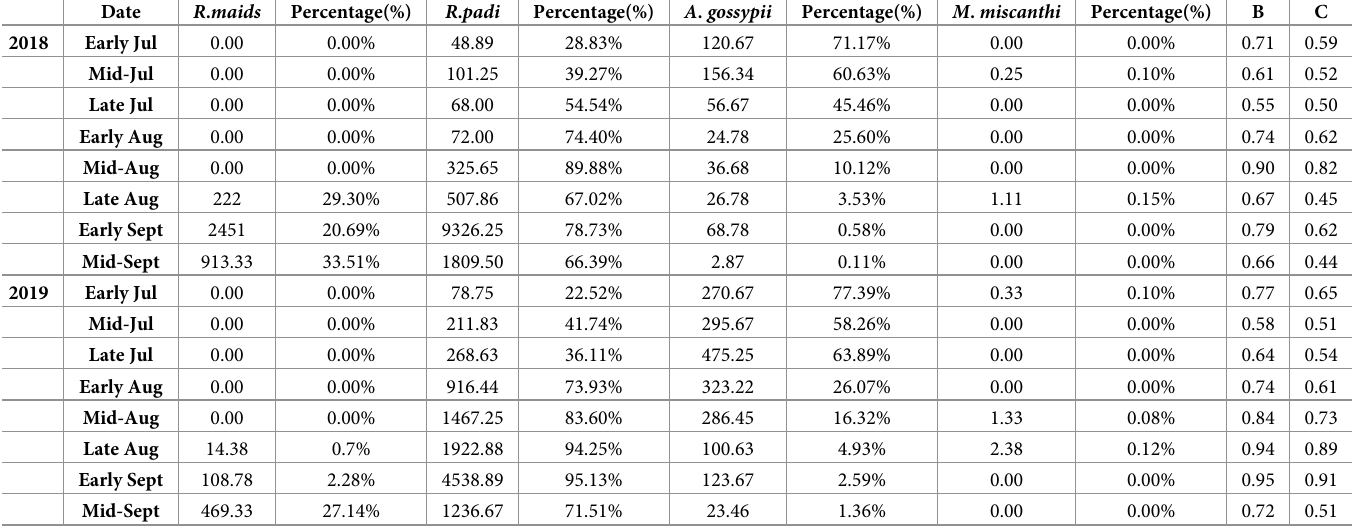
Table 3. The population dynamics and dominance of aphids in the Huinan area maize field in 2018 and 2019.